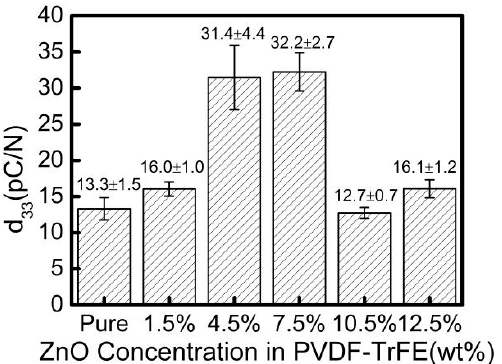
Figure 8. Piezoelectric strain constant d 33 of the PVDF-TrFE/nano-ZnO films with different nano-ZnO contents.